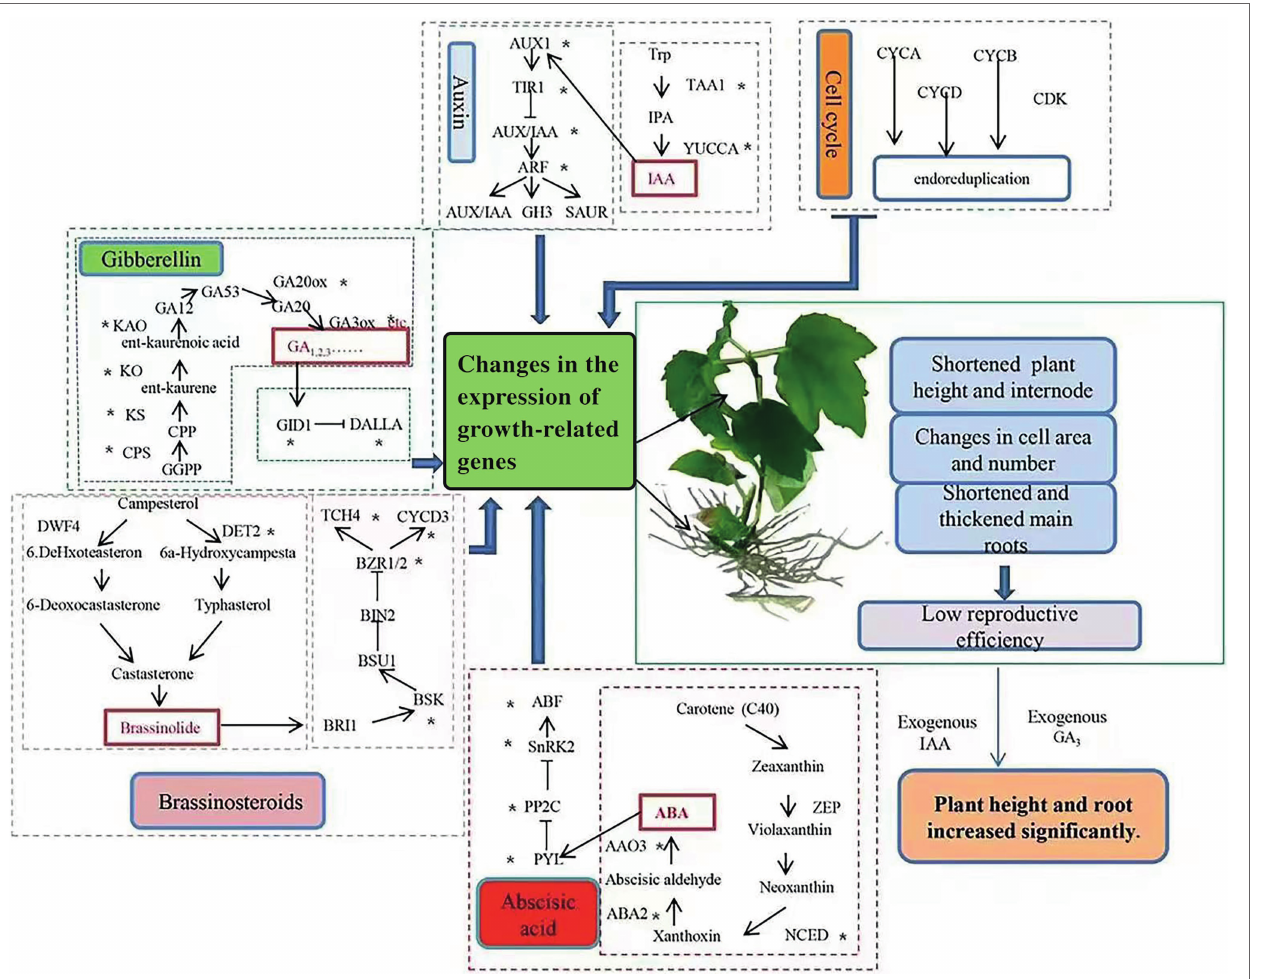
FIGURE 11 | Effects of changes in endogenous hormone biosynthesis and signal transduction genes and supplementation with exogenous hormones on tetraploid hybrid sweetgum growth. ‘*’ indicates DEG enrichment in roots or